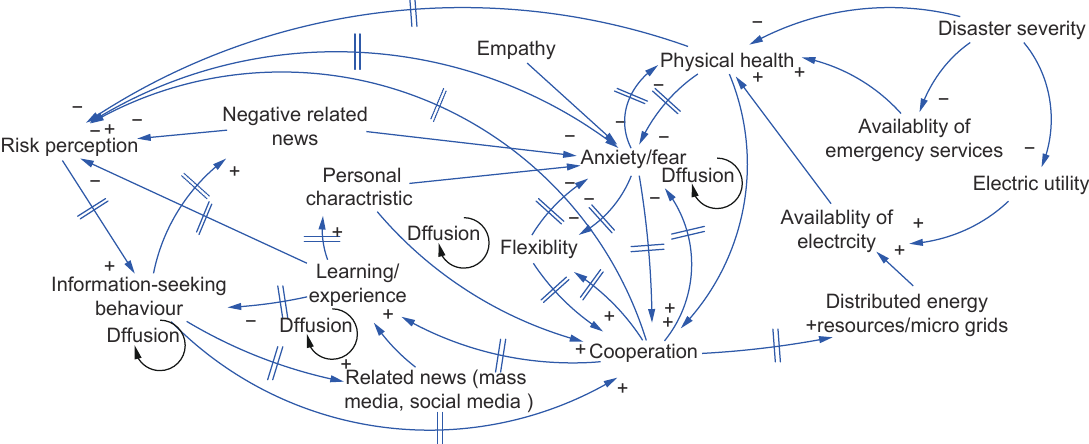
Fig. 2 System dynamical model of power system, emergency services and human (agent) response to a disaster. It is worth noting that social networks contain a large number of agents who influence one another through social behavioral